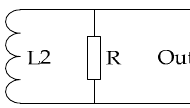
Figure 5. The electromagnetic field along the x -axis. The power spectrum of the arc fault can be expressed as:  